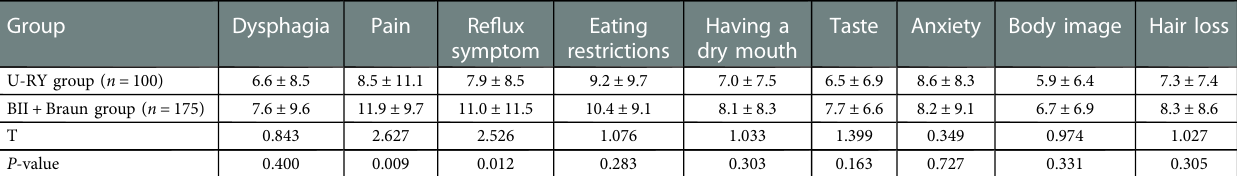
TABLE 3 Comparison of QLQ-STO22 score items between the two groups in 1 year after surgery.